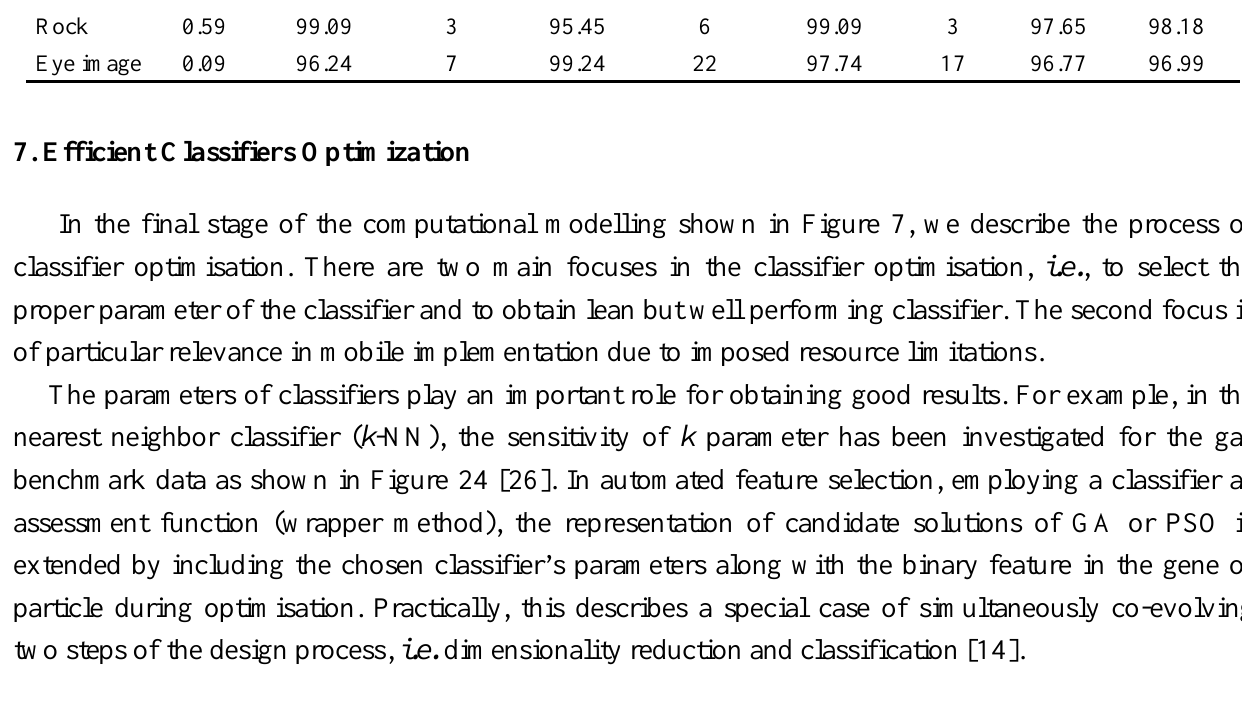
Figure 24. Sensitivity investigation of k –NN using extracted features by Gaussian kernel (GWF) of gas benchmark data. The k parameter values are set as 1, 3, 5, 7, and